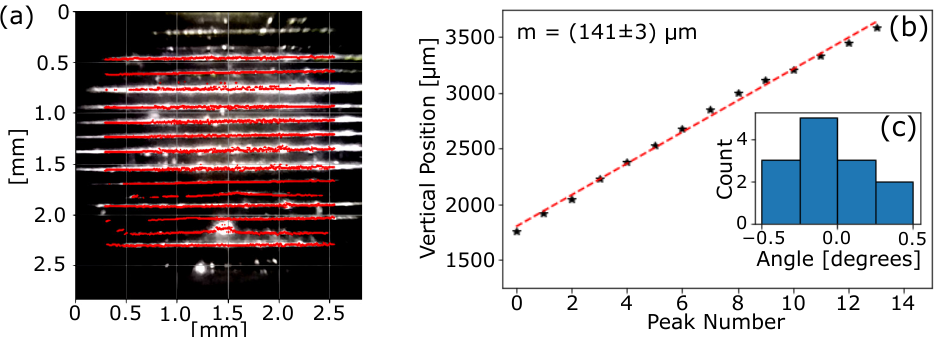
Figure 2. ( a ) Microscope image of assembled TARP device with peak locations labelled with red dots. Peaks are detected along each vertical slice of pixels. Peak locations along a single horizontal prism are fit to a line which is then used to determine prism spacing and alignment. ( b ) The y-intercepts of each linear fit from ( a ) are plotted and fit to a line. The slope of this line corresponds to the average spacing of the prism peaks. The y-intercept of this line indicates the position of the first prism peak relative to the top of the camera and therefore is not shown in this plot. ( c ) Histogram of the slope of fit lines from ( a ). This shows that prism alignment has a standard deviation of ± 0.3 ◦ .